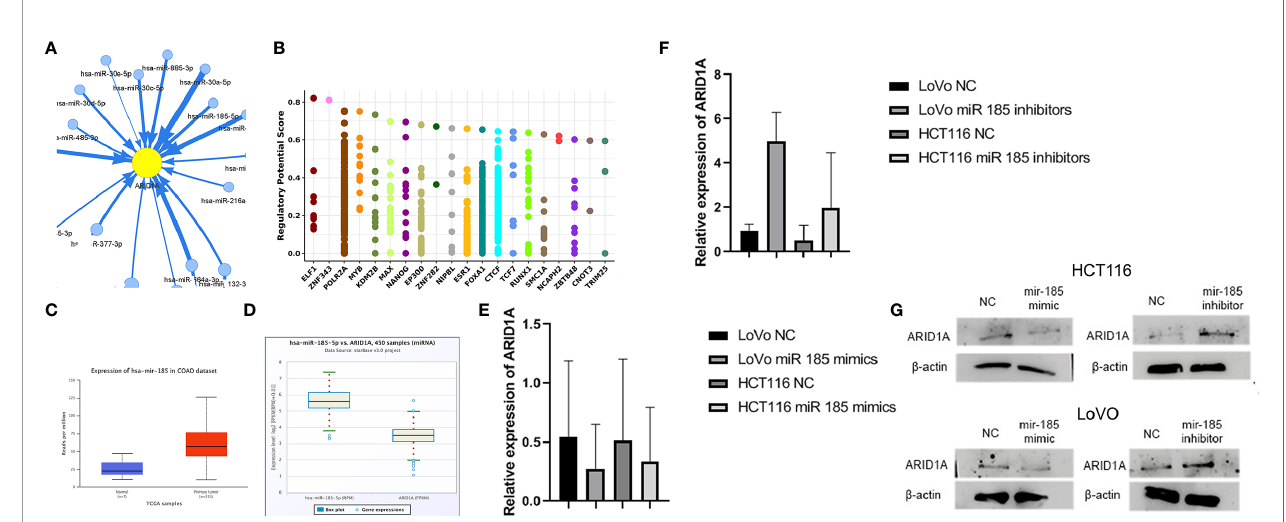
FIGURE 3 | Mir-185 downregulates ARID1A in colon cancer. (A) ARID1A can be controlled by mir-185-5p; (B) Transcription factors that regulate ARID1A expression from Cistrome (Chip-Seq data); (C) Mir-185 is overexpressed in COAD; (D) ARID1A is negatively correlated with mir-185-5p in COAD; (E, F) Mir185 mimics and inhibitors results detected by qPCR; (G) Mir185 mimics and inhibitors results detected by western